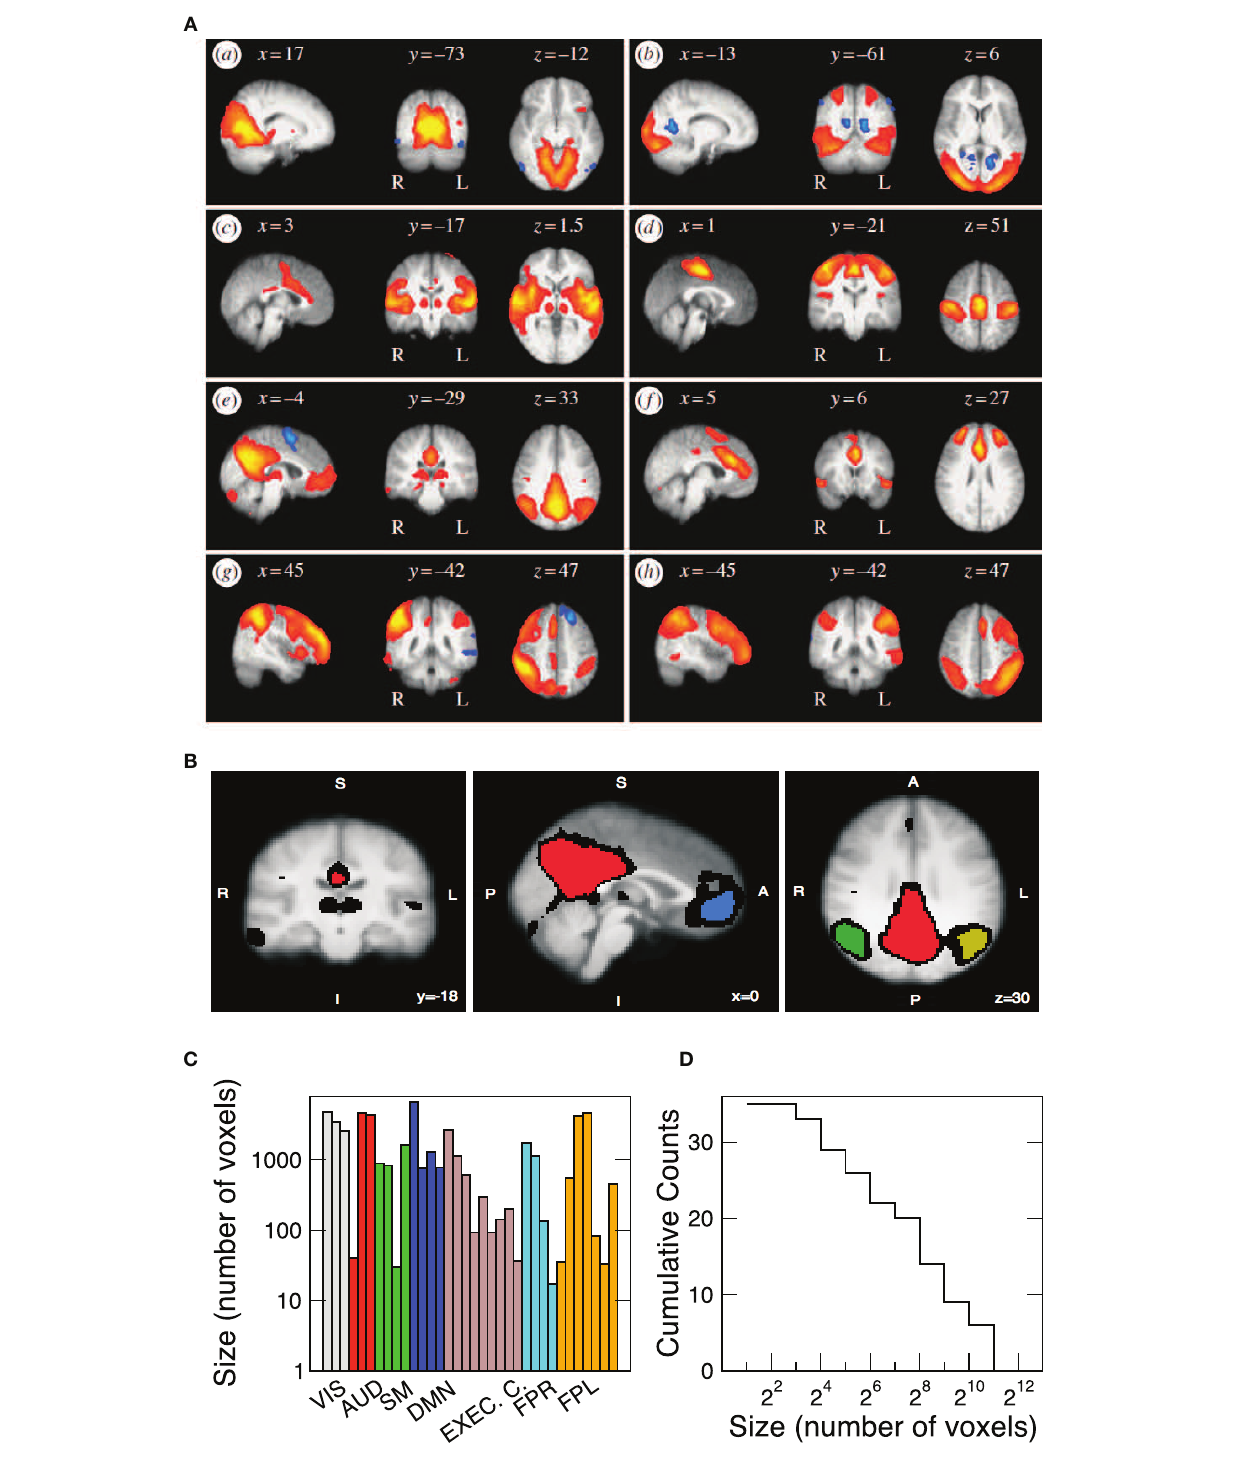
FIGURE 1 | (A) Spatial maps of the eight most relevant brain resting networks as described by Beckmann et al. (2005). Each map shows the locations of each RSN (shown in sagittal, coronal, and axial views) where the coordinates refer to mm distances from the anterior commissure. Label VIS corresponds to visual; AUD to auditory; SM to sensory motor; DMN to default model network; EXEC. C. to executive control; FPR and FPL to